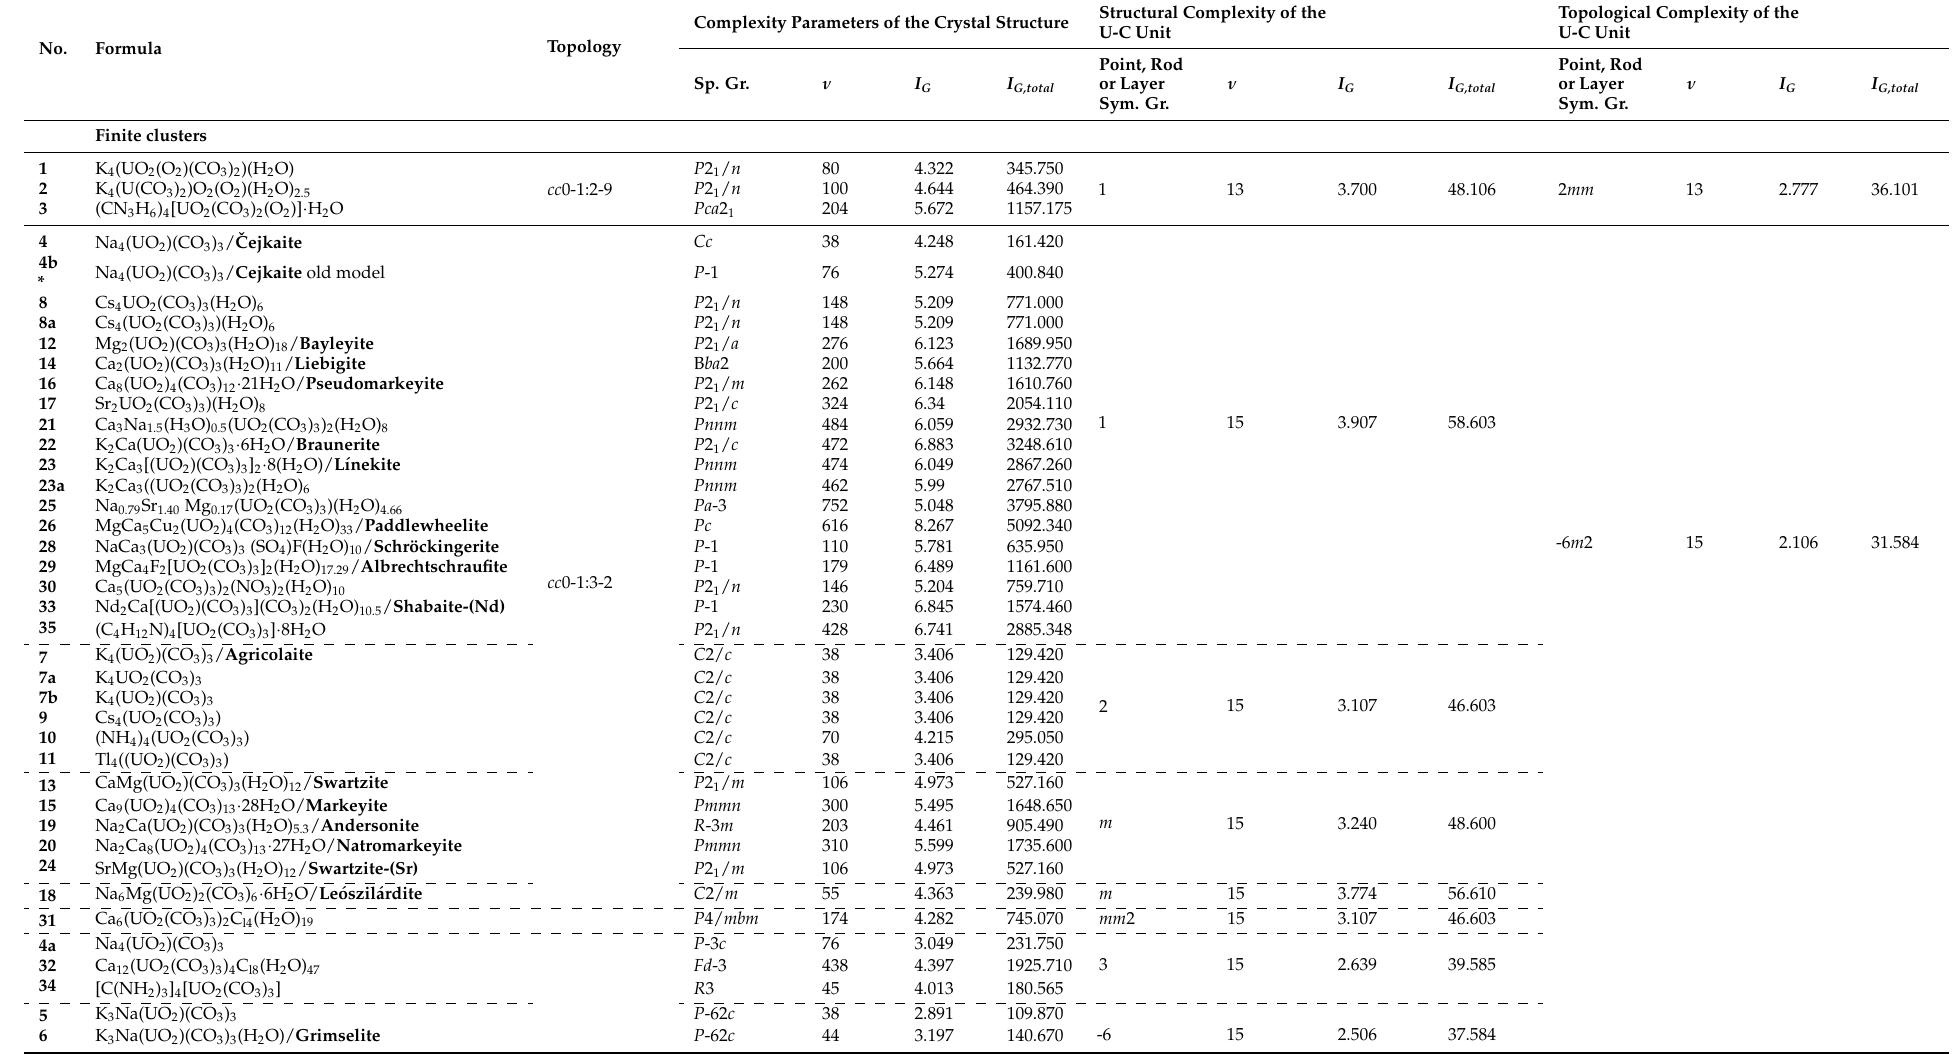
Table 2. Structural and topological complexity parameters for the uranyl carbonate